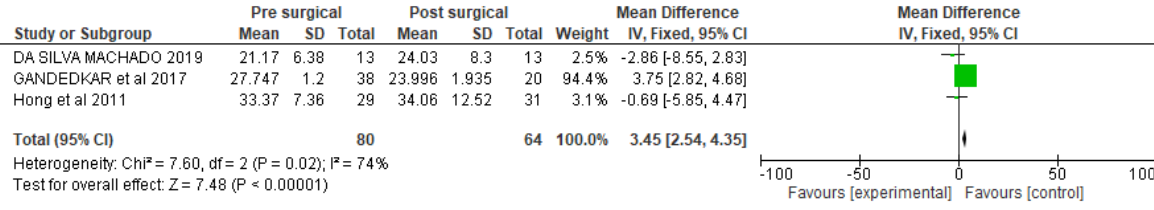
Figure 12. Forest plot for Surgery class III between pre and post surgery.